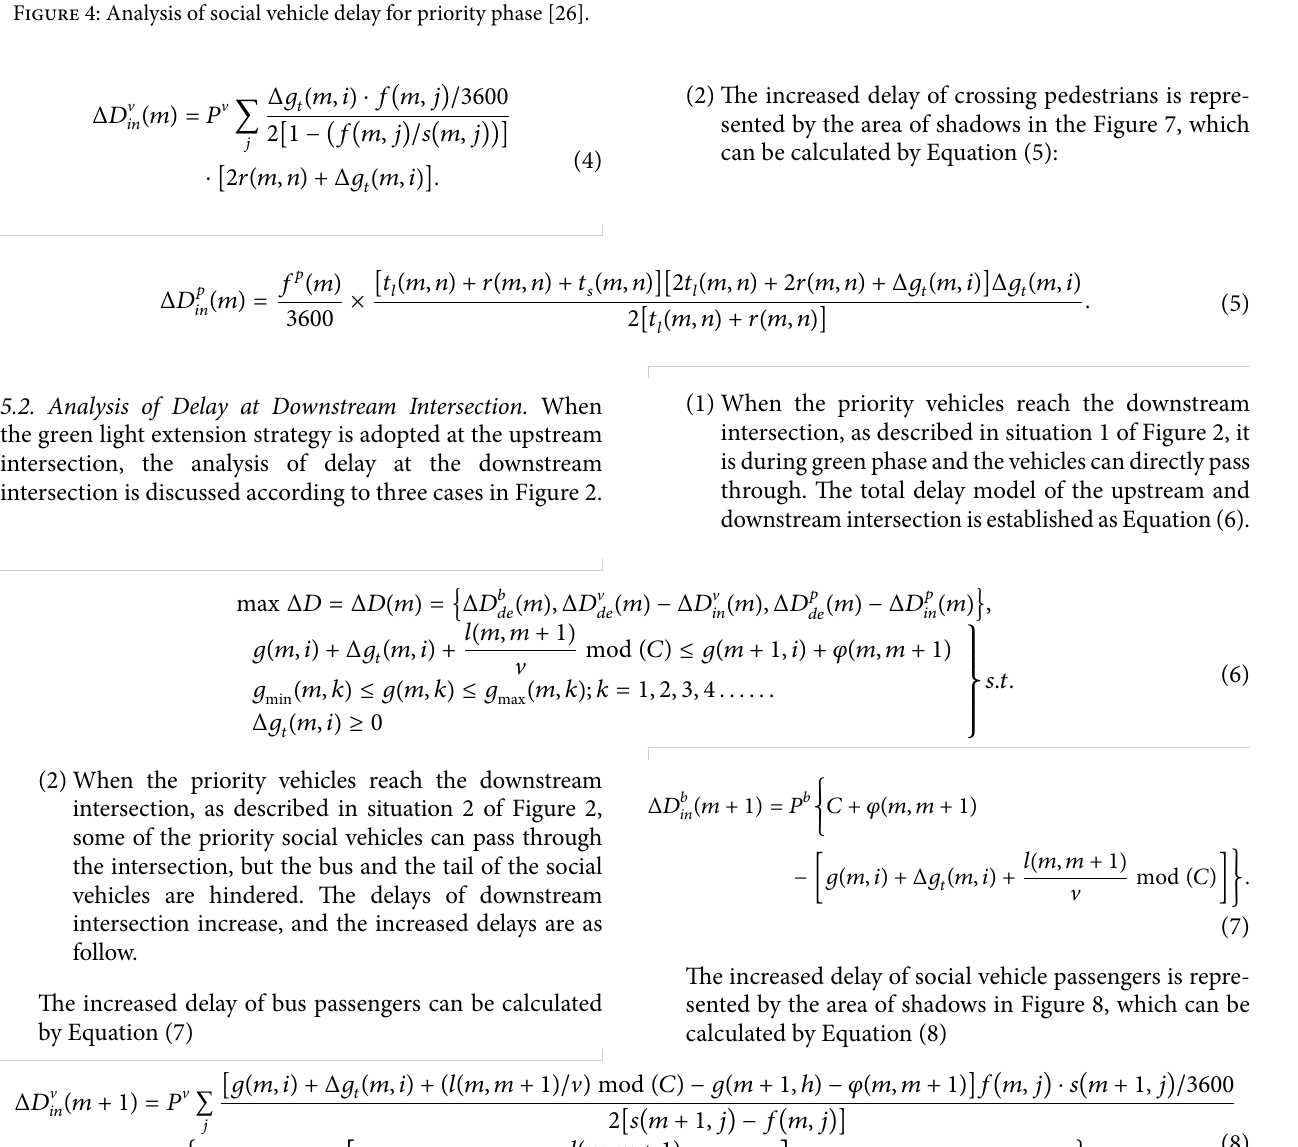
Figure 4: Analysis of social vehicle delay for priority phase